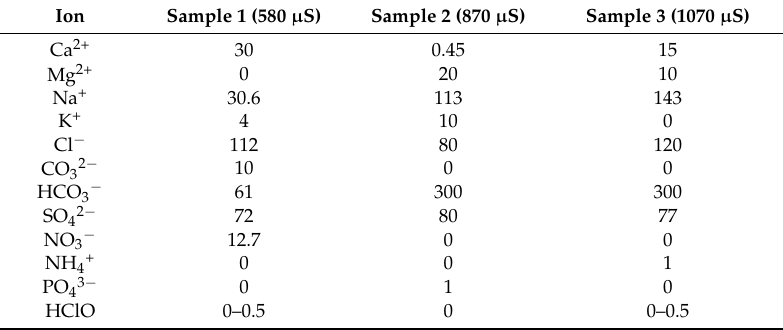
Table 1. Ions in the test samples (mg/L).